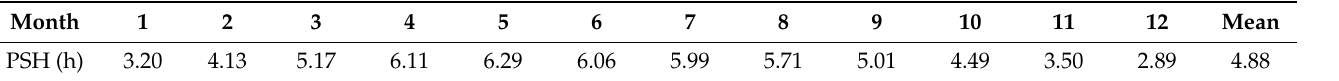
Table 3. Peak sunshine hours in